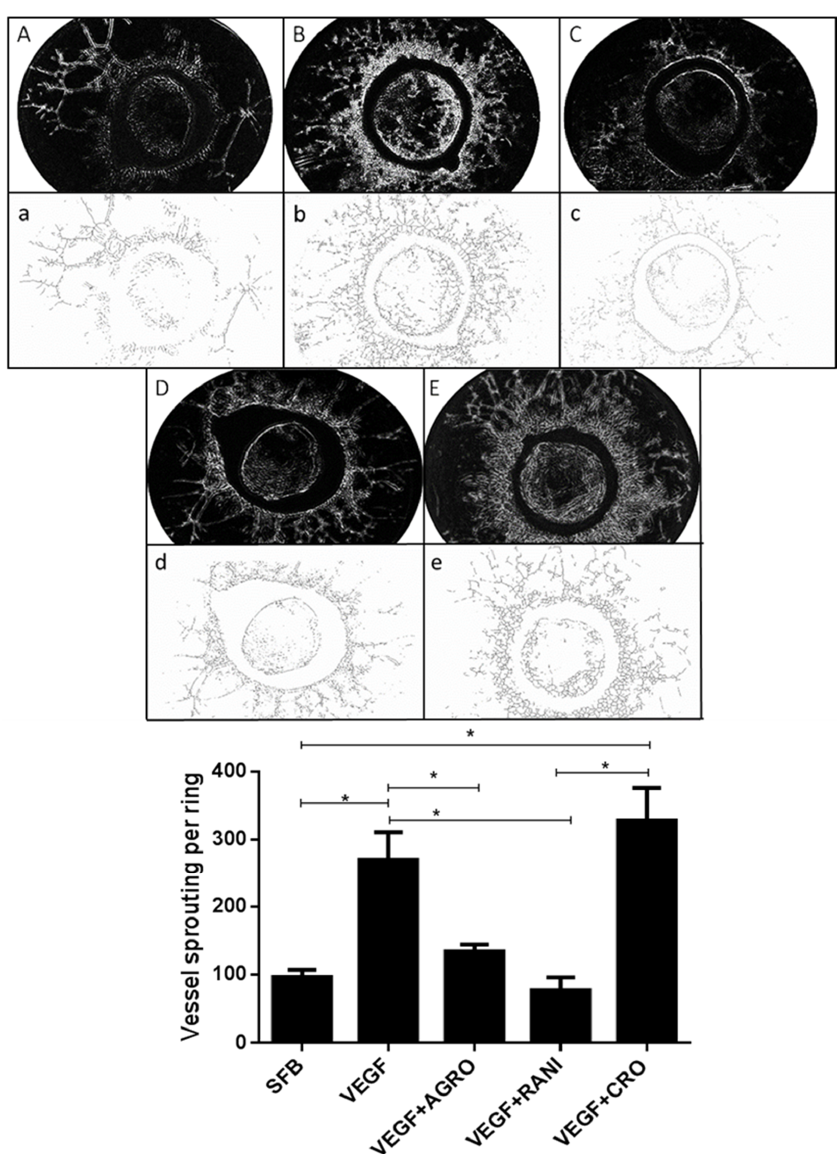
Figure 4. AS1411 reduced vascular sprouting in the rat aortic ring assay. Top panel. Rat aortic rings were cultured for 7 days in matrigel without rhVEGF ( A ,a) or with rhVEGF ( B ,b– E ,e) in matrigel. The sprouting vessels were visualized and photographed in an inverted microscope, the photographs were converted to 8-bit images (Capital letters) and analyzed and skeletonized using WEKA software (lower-case letters). Control group (A,a); rhVEGF alone group ( B ,b); rhVEGF+AS1411 group ( C ,c); rhVEGF+ranibizumab ( D ,d) and rhVEGF+ CRO ( E ,e). Vascular neoformations extended predominantly in a radial shape outwards the aortic rings, besides vascular neoformations extended inwards aortic rings in a minor proportion. Representative images of 15 rings per condition. Bottom panel. The vessels sprouting per aortic ring were compared among the 5 groups. Bars represent the mean ( ± SE). n = 15 rings per condition. * p <